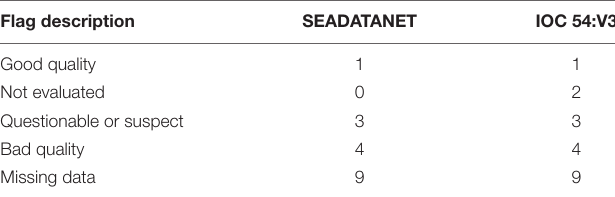
TABLE 2 | Data quality control flag translation table, IOC 54:V3 to SeaDataNet. Flag